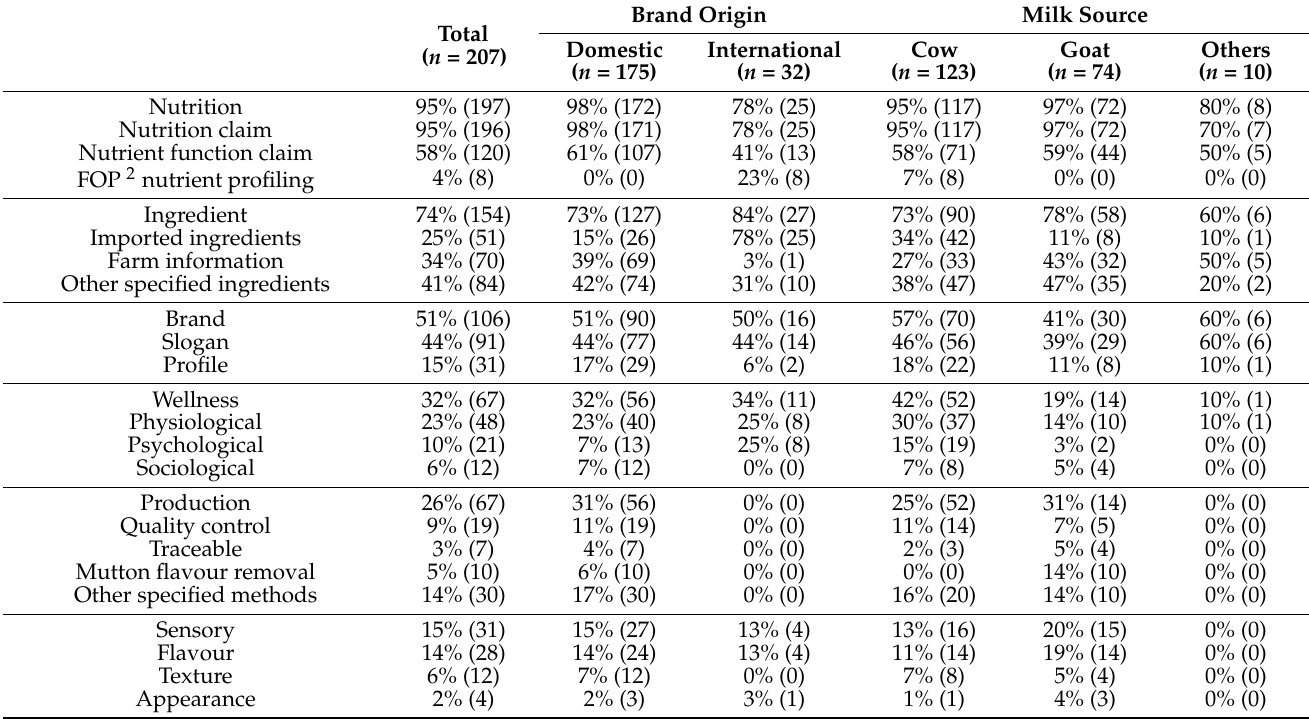
Table 4. Percentage and number of milks targeting Chinese older adults providing textual voluntary well-being messaging by total, brand origin and milk source 1 .